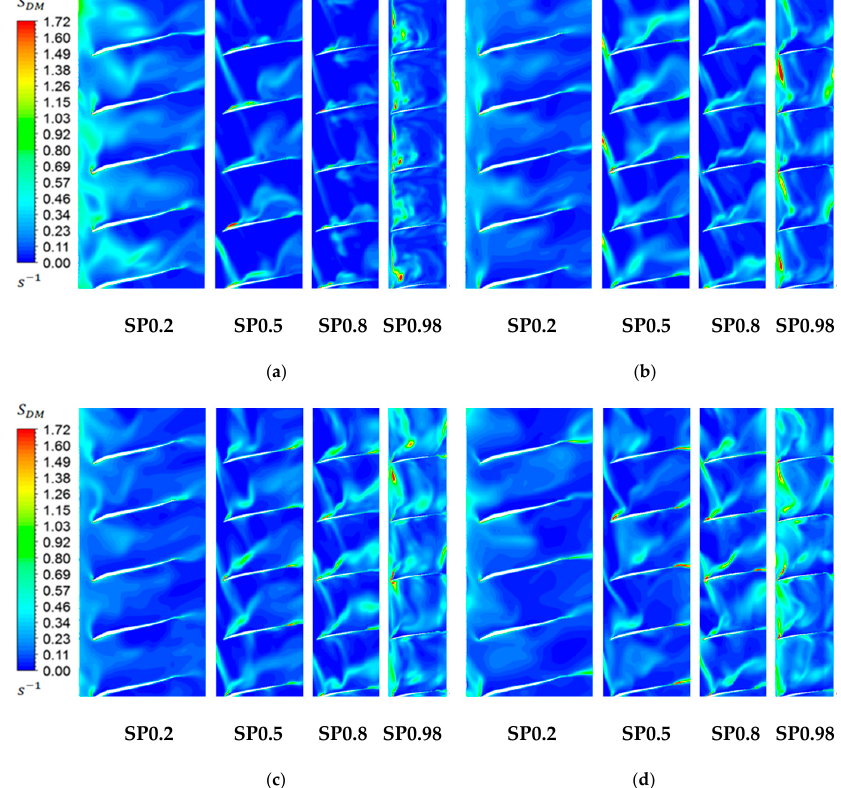
Figure 15. Distributions of S DM (reflecting the turbulent entropy generation rate) on di ff erent spanwise surfaces of the di ff user with varying discharge (( a ) ϕ = 0.4; ( b ) ϕ = 0.354; ( c ) ϕ = 0.329; and ( d ) ϕ =